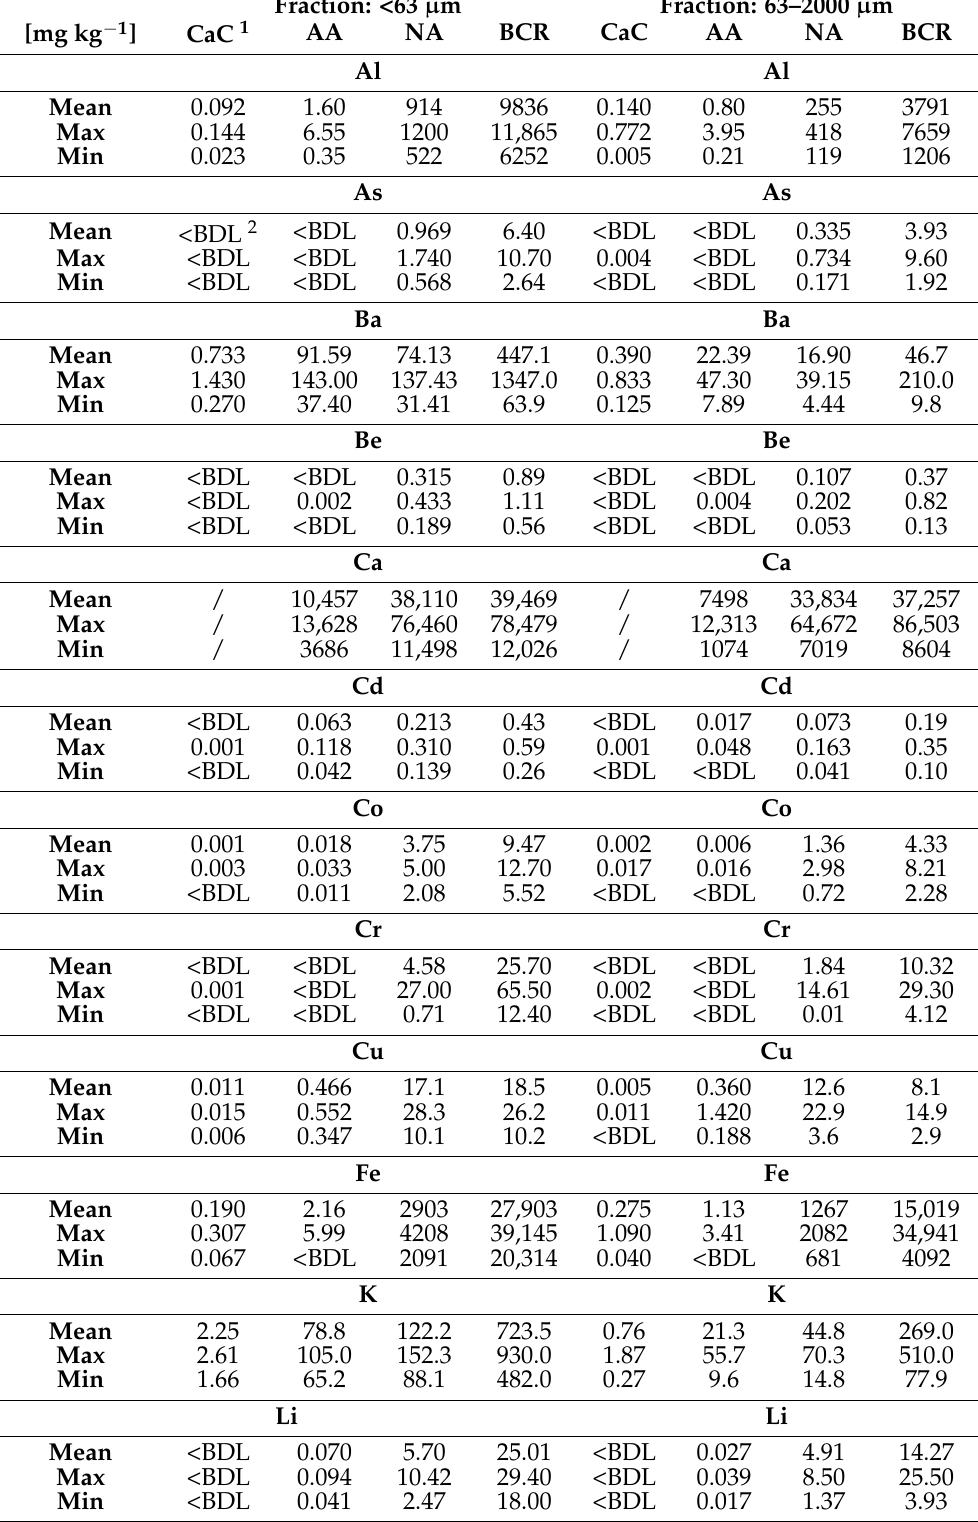
Table 3. Statistical analysis of elements’ contents (Al, As, Ba, Be, Ca, Cd, Co, Cr, Cu, Fe, K, and